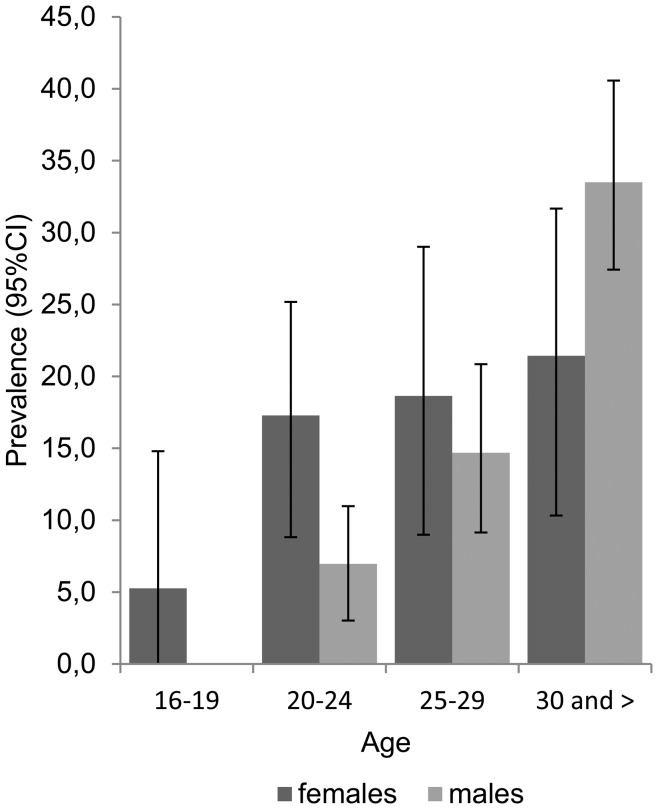
HIV prevalence with 95% confidence intervals stratified by gender and age, in a cross-sectional study conducted in Poland, 2004–2005.Of the 748 respondents to the original survey, 137 (18.3%) had a positive test result for HIV. Upon age stratification, females in younger age groups tended to have a higher level of HIV infection compared to males. Overall, HIV prevalence among females and males aged <30 years (analyzed subset of the original dataset) was 16.4% and 9.6%, respectively. Among those ≥30 years, the relative proportions were reversed: HIV prevalence was 21.4% among females and 33.5% among males.